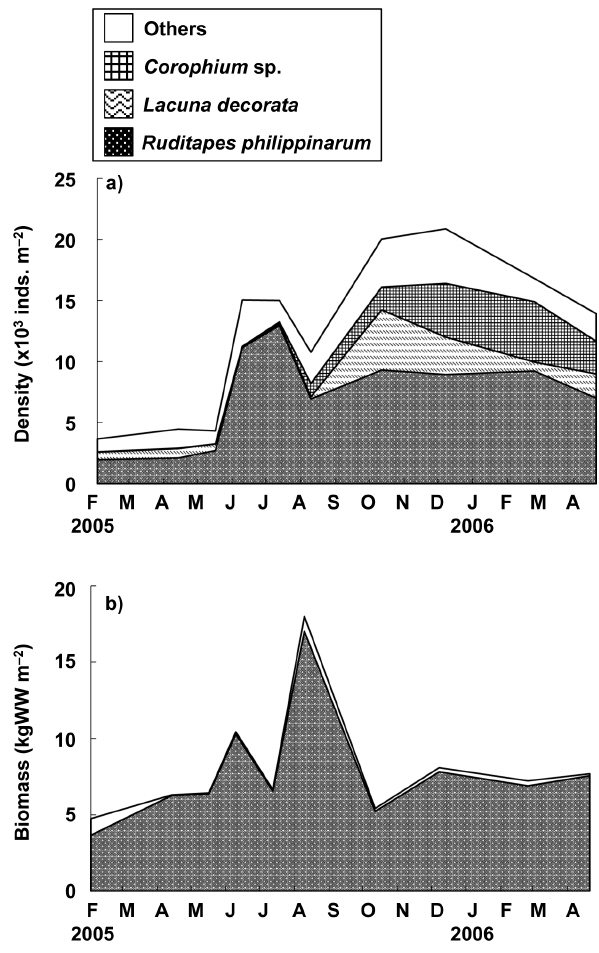
Figure 2. Seasonal variability of the macrobenthic animals at station B. (a) density and (b) biomass.